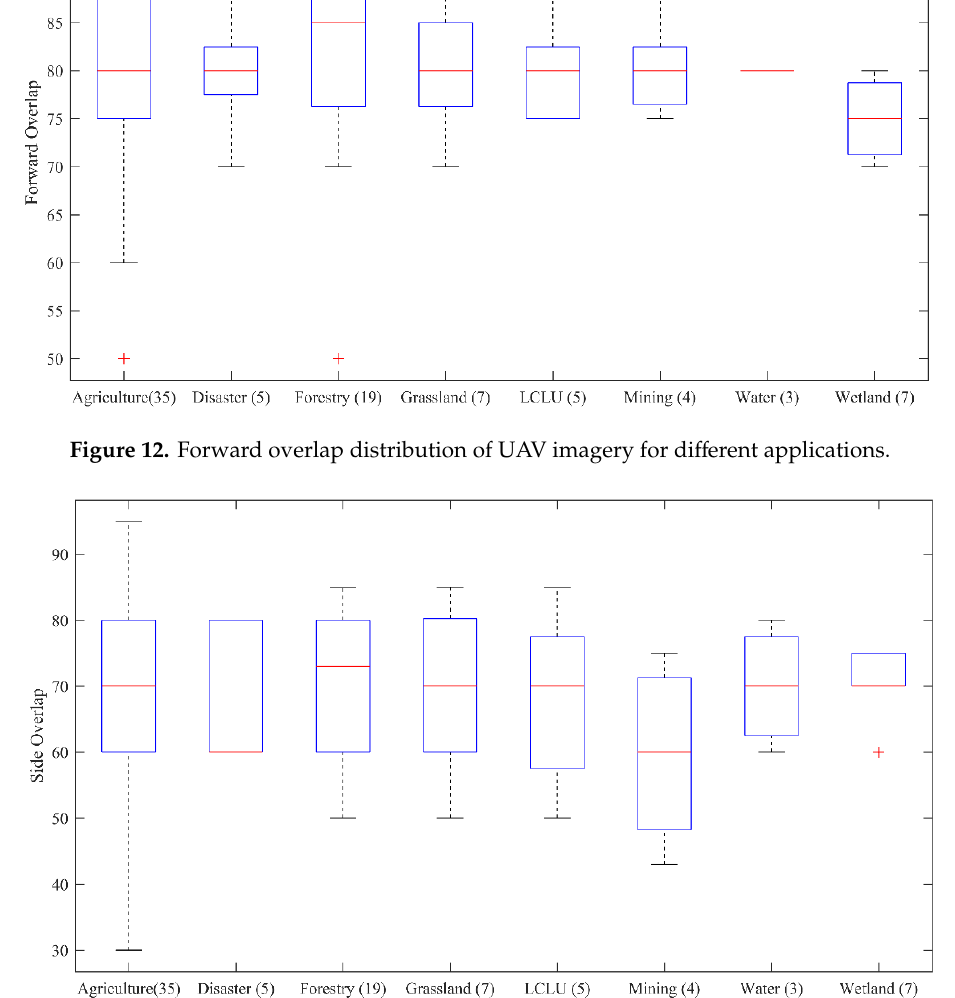
Figure 13. Side overlap distribution of UAV imagery for different applications.